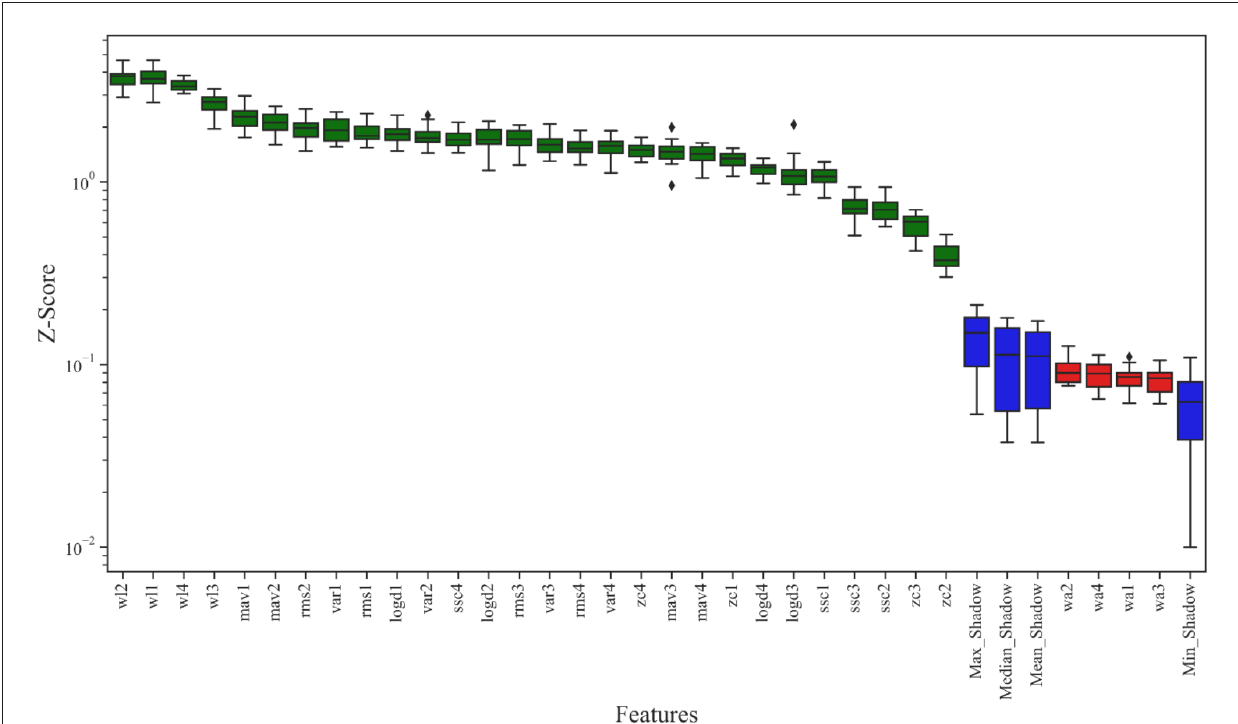
FIGURE8 Result of the Boruta algorithm: Z-Score was used to represent the feature importance. The features suggested to be excluded are marked in red, features more related to the dependent variables are marked in green, and the shadow features are marked in blue.